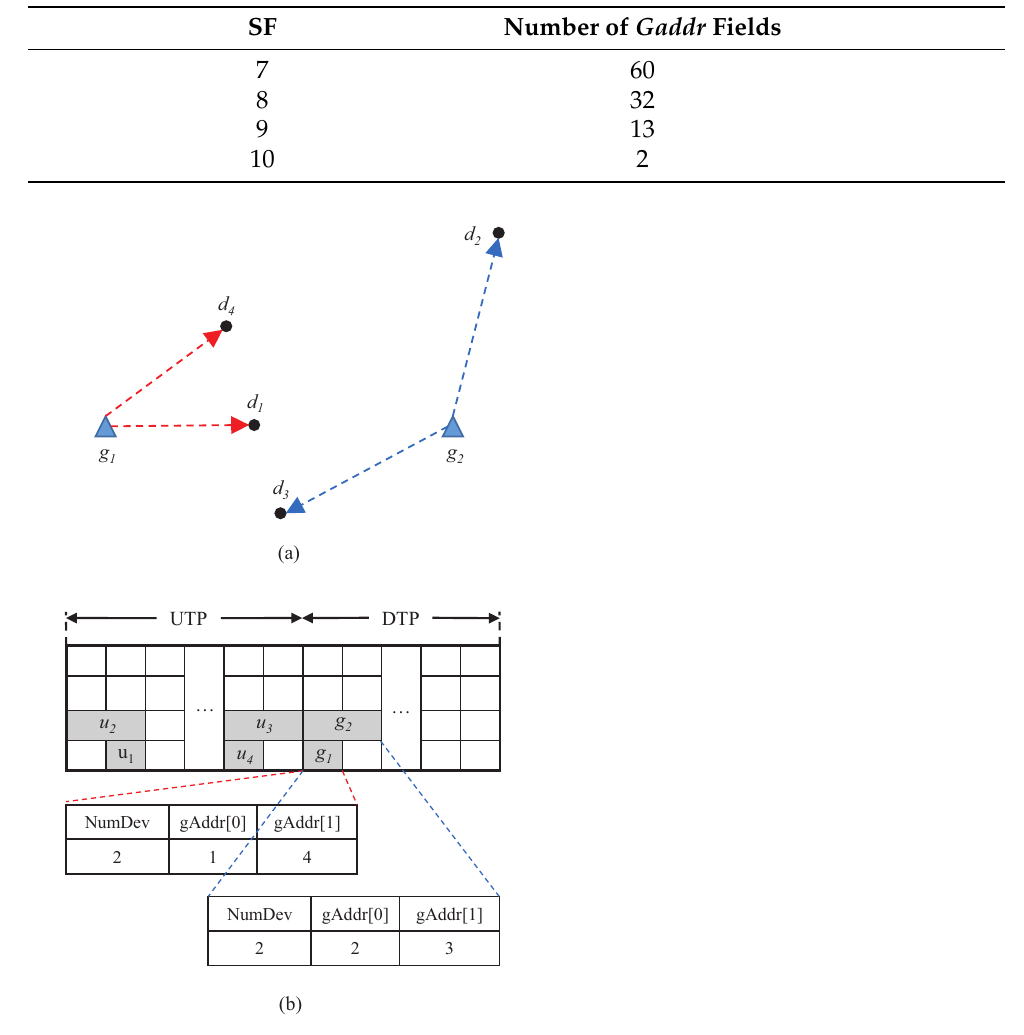
Figure 4. Illustration of exchanging GACKs in the network with multiple gateways. ( a ) Multiple GACK transmissions from two gateways. ( b ) Description of NumDev and gaddr fields in